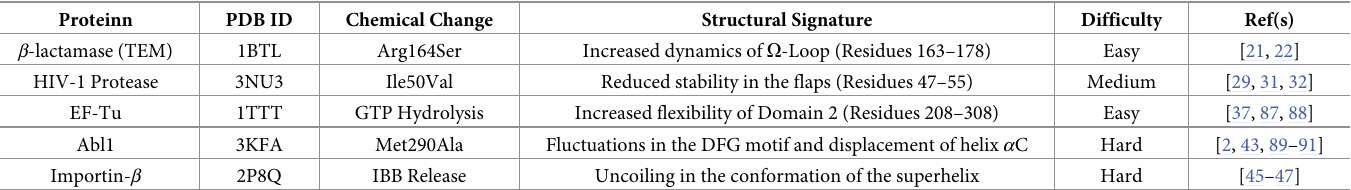
Table 2. Detailed overview of the different protein systems analyzed in this study. The columns of this table are arranged as follows: (1) the name of each protein stud- ied; (2) the corresponding Protein Data Bank (PDB) ID for each molecule [92]; (3) the known chemical change or mutation type that is considered; (4) the specific struc- tural signatures that are known to be associated with each chemical change or mutation type; (5) the presumed difficulty level for SINATRA Pro to detect each structural signature based on the homogeneity in shape variation between the wild-type and mutant proteins; and (6) references that have previously suggested some level of associa- tion or enrichment between each structural change and the mutation of